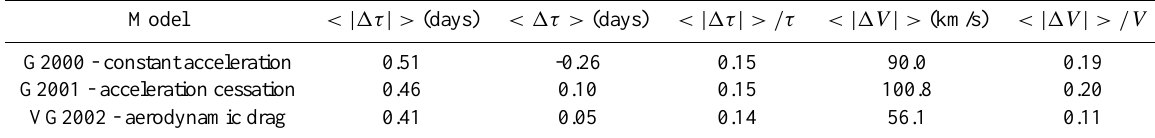
Table 2. Comparison of models with the observations of the 35 E-S line CMEs. Model